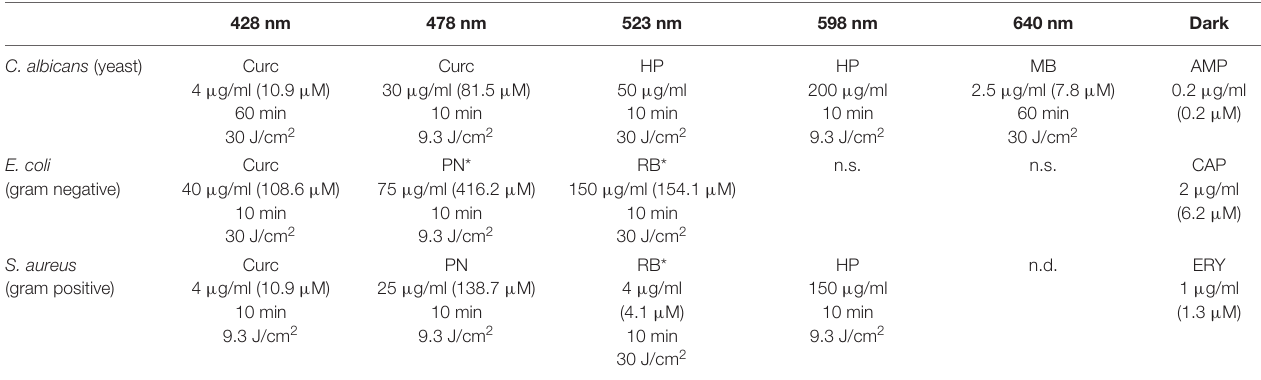
FIGURE 5 | Absorbance spectra of positive controls (PCs) versus emission spectra of the LED modules ( λ irr = 428, 478, 523, 598, and 640 nm from left to right). TABLE 2 | Overview of the minimal inhibition concentrations under irradiation (PhotoMIC) of the investigated positive controls regarding the three tested microorganisms